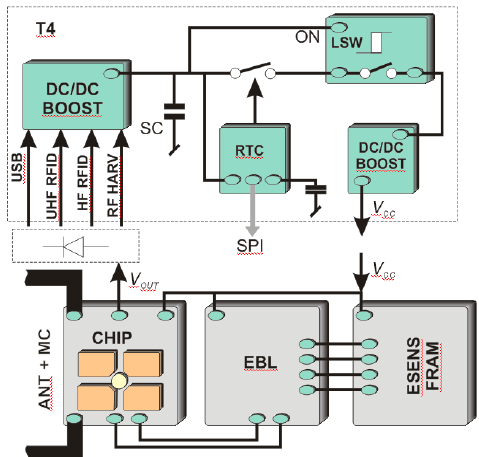
Figure 8. Diagram of advanced power supply circuit dedicated to fully autonomous transponder. DC/DC BOST—ultra efficient step up switching regulators Silicon Labs TS3310; SC—supercapacitor Cellergy CLC03P025F12; LSW—ultra low ON-resistance load switch with controlled turn on with hysteresis Texas Instruments TPS22934; RTC—low power real time clock Abracon AB1815.